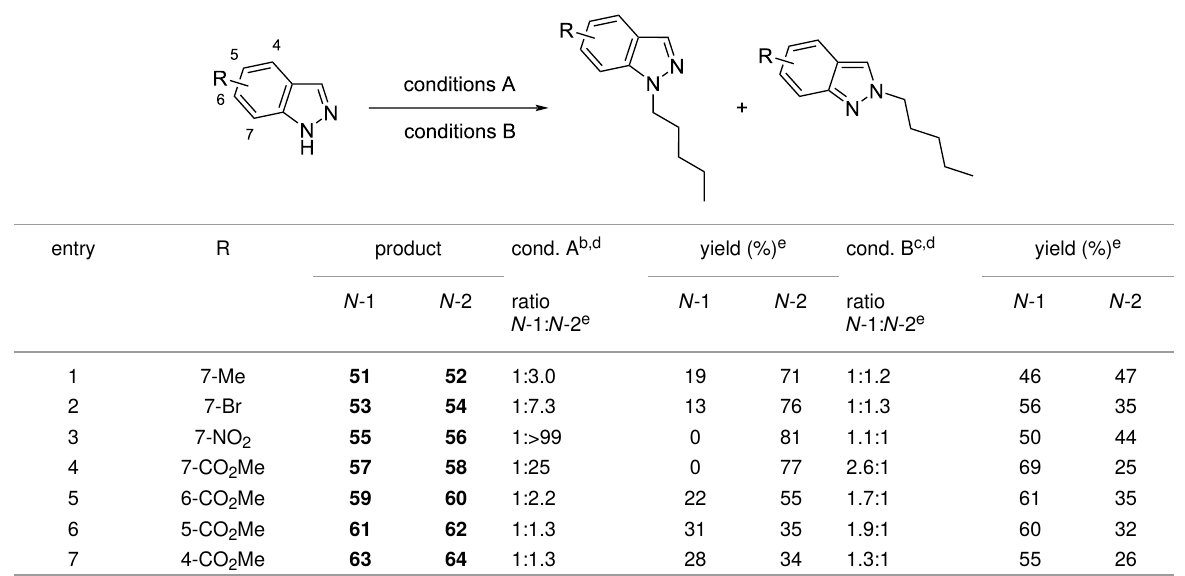
ence for the formation of the corresponding N -1 regioisomer (Table 4, entries